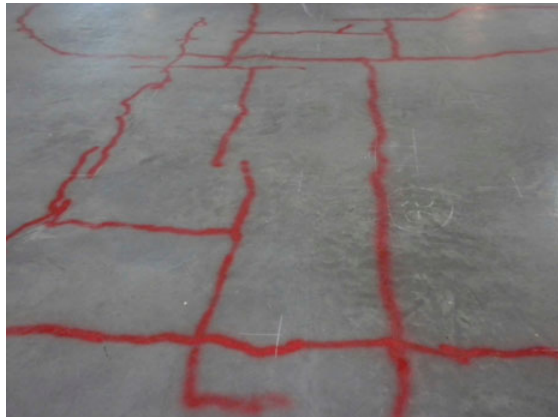
Fig. 5. View of the situation of cracks in concrete floor slab